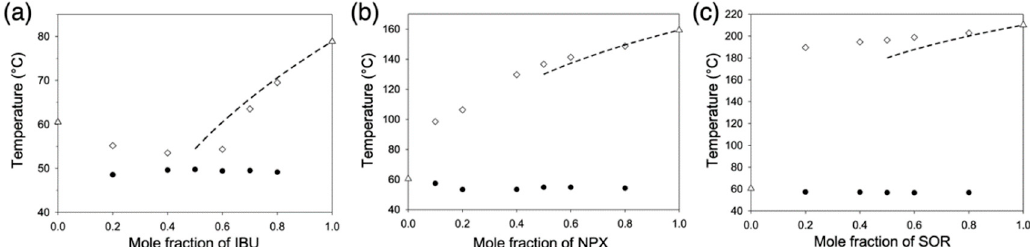
Figure 2. Melting diagrams of ( a ) IBU / octadecanol (OD), ( b ) NPX / OD, and ( c ) SOR / OD mixtures. Dotted lines indicate ideal behavior calculated with the van’t Hoff equation; empty triangles melting points of pure components; empty diamonds liquidus temperatures; filled circles solidus temperatures.